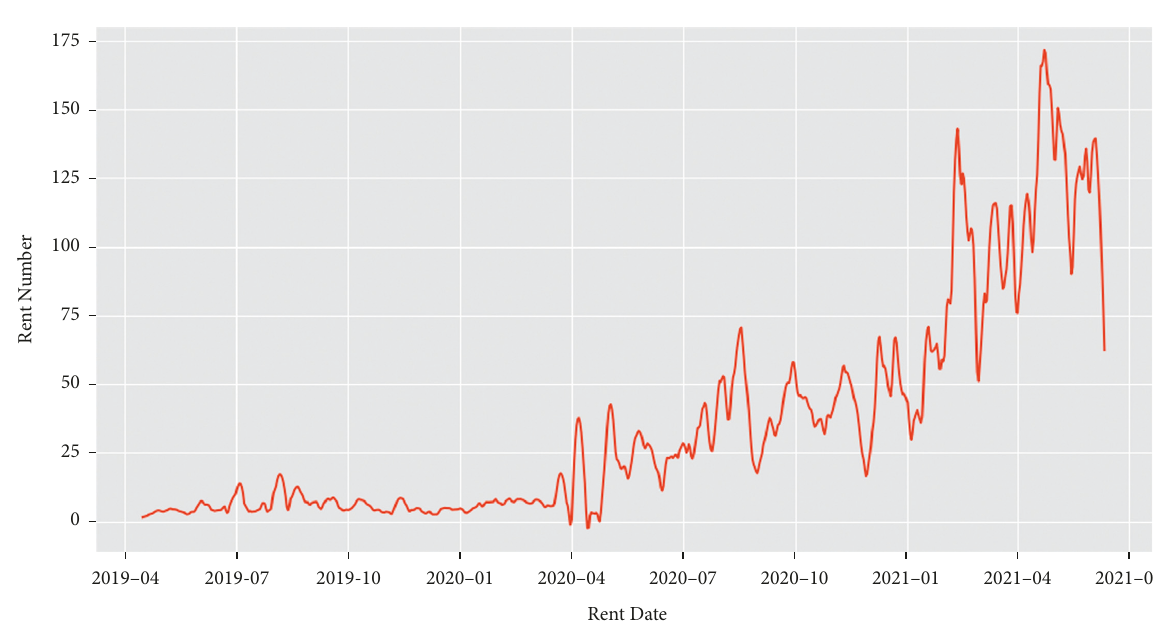
Figure 7: Daily demand for electric kickboards after smoothing the